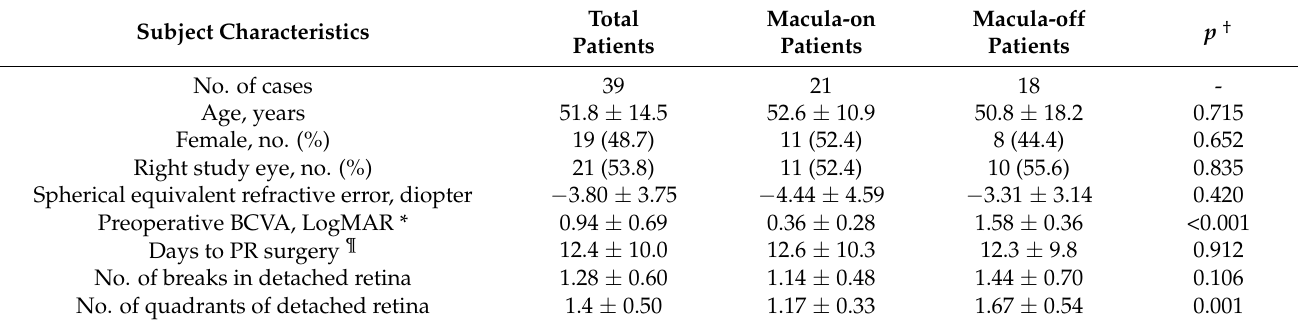
Table 1. Preoperative clinical characteristics of uncomplicated RRD patients.